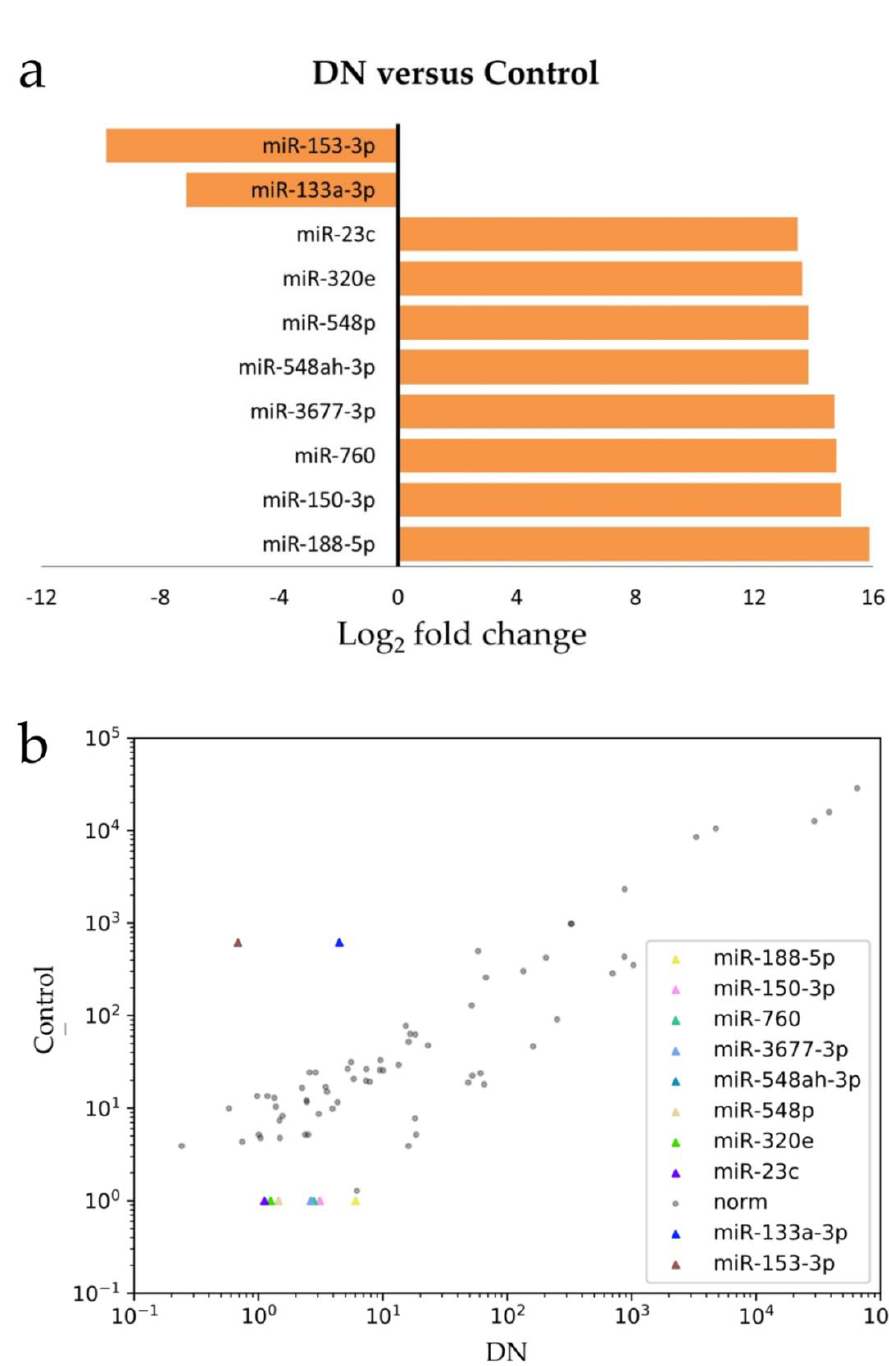
Figure 2. The most deregulated miRs in DN: (a) the differentially-expressed miRs in DN (versus control) are shown in Log 2 fold change, with a positive value referring to up-regulation and a negative value meaning down-regulation; (b) the scatter plot shows that these deregulated miRs exhibited correlated-expression pattern between DN and control.